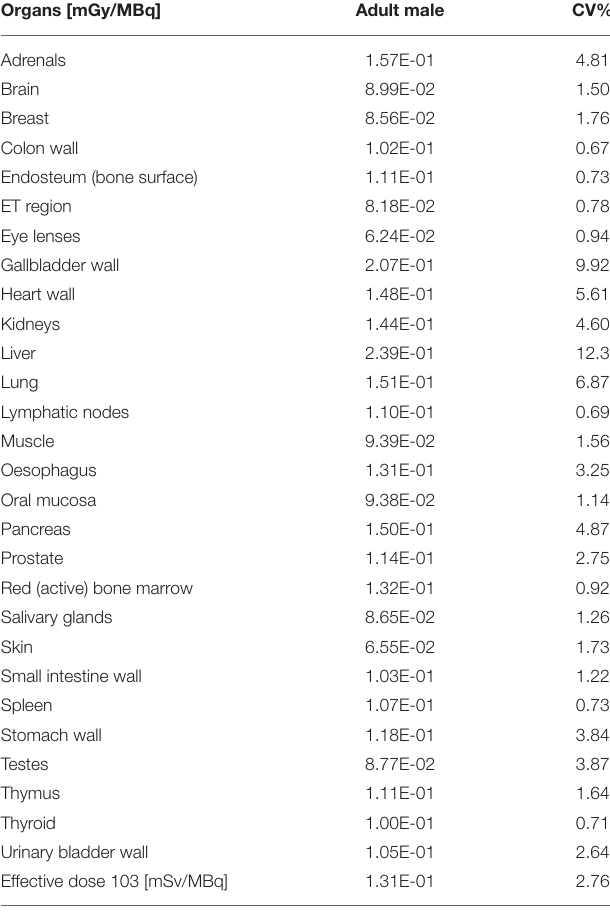
TABLE 3 | Human extrapolated dosimetry with [ 89 Zr]DFO-anti-PDL1 (IDAC-Dose) based on 7 healthy